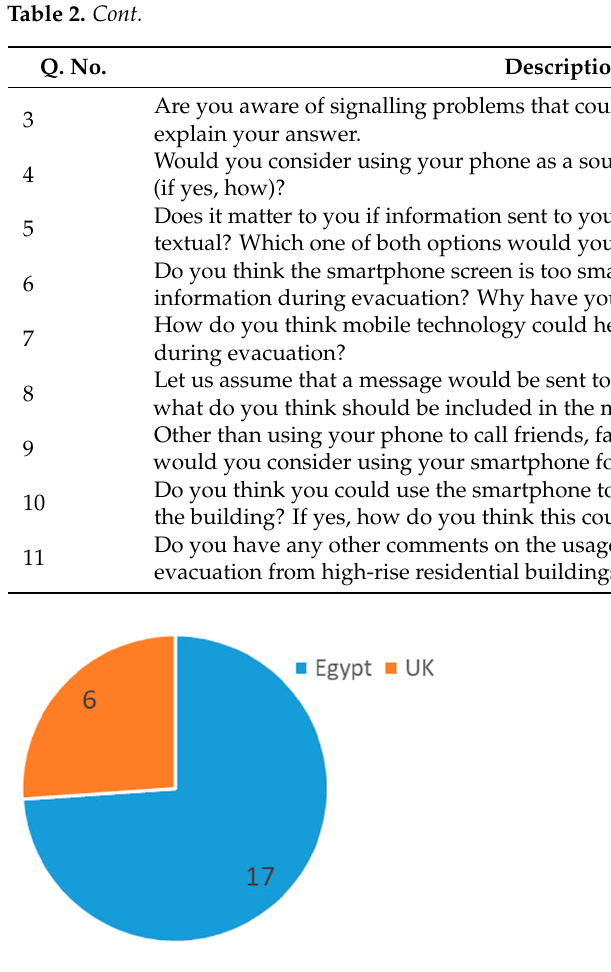
Figure 1. Distribution of interviewees by country. Table 2. Semi-Structured Interview